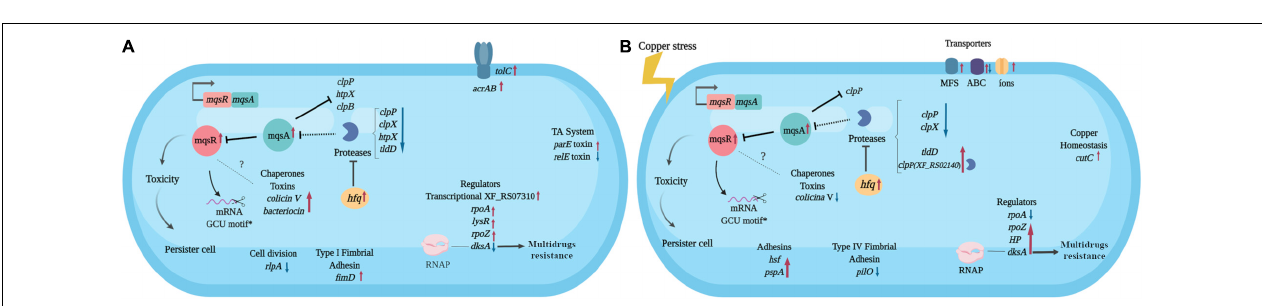
FIGURE 5 | Gene Ontology categorization of differentially expressed genes in X. fastidiosa overexpressing mqsR in response to copper. (A) Genes were classified by functional category of biological processes using Blast2GO. (B) Categorization of differentially expressed genes unique to Xf-mqsR in response to copper. UP: upregulated genes; DOWN: downregulated genes.